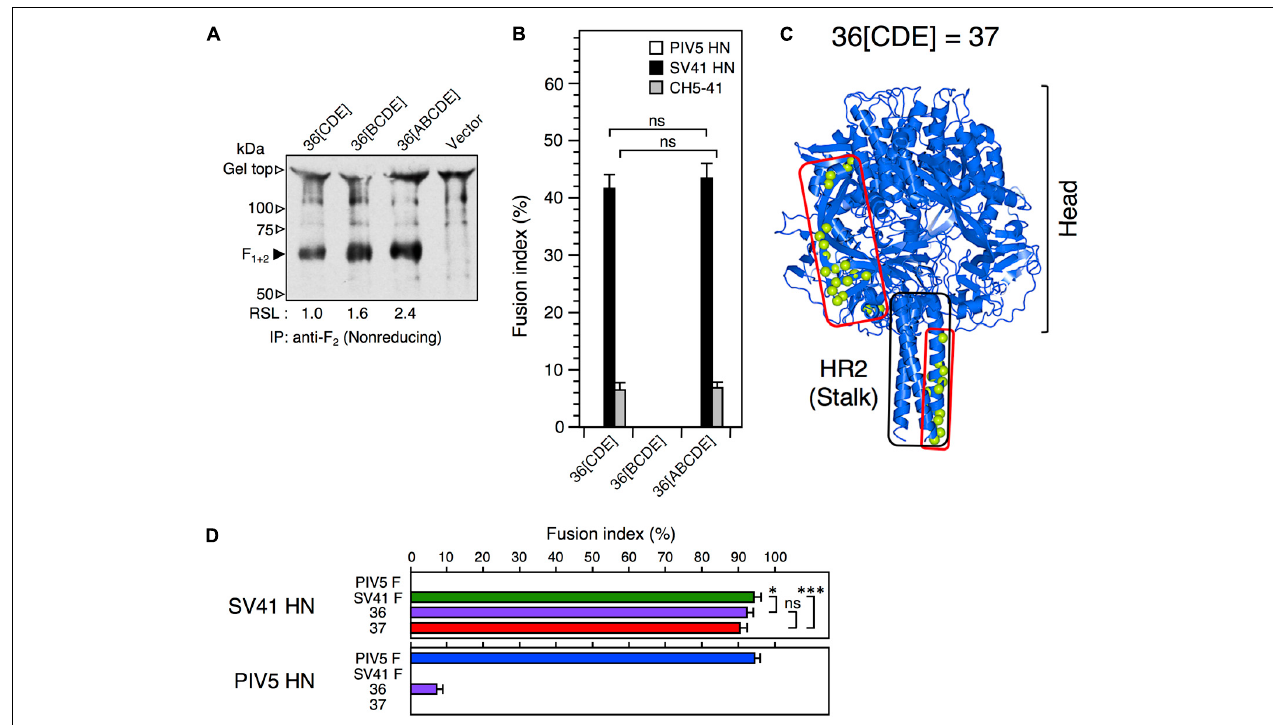
FIGURE 3 | No. 37 is a more SV41 F-like protein than no. 36. (A) Detection of the F proteins in the plasmid-transfected cells. Subconfluent BHK cells in six-well culture plates were transfected with 2 µ g/well of F expression vector. The biotinylated F proteins expressed on the cell surface were detected by immunoprecipitation with anti-PIV5 F 2 rabbit serum as described in the legend for Figure 1C . Vector: pcDL-SR α expression vector used as the negative control. RSL, relative surface localization. (B) HN protein specificity of the F proteins. Subconfluent BHK cells in six-well culture plates were transfected with 2 µ g/well of the pcDL-SR α expression vector encoding each F protein together with 1 µ g/well of the pcDL-SR α expression vector encoding each HN protein. After 12 h of incubation, the cells were fixed with 4% paraformaldehyde and the average fusion index was determined as described in the section “Materials and Methods”; error bars indicate standard deviation. The representative data of more than three independent experiments are shown. The fusion indices are not normalized to the cell surface-localization levels; the normalized data are shown in Supplementary Figure S5B . The statistical significance was evaluated by one-way ANOVA as described in the section “Materials and Methods”. ns, not significant. (C) Predicted three-dimensional structure of no. 37. The side view of the no. 37 trimer is drawn as a ribbon model on the basis of the crystal structure of PIV5(WR) F protein (PDB ID: 4WSG). The amino acid sequence identify between the ectodomains (amino-terminal 477 residues) of no. 37 and the PIV5 F protein is 93.6%. Light green balls surrounded by red lines indicate the positions of SV41 F-derived 36 amino acids; those in only one protomer are shown for clarity. (D) F protein specificity of the HN proteins. Subconfluent BHK cells in six-well culture plates were transfected with a mixture of 0.2 µ g/well of each HN-encoding vector and 2 µ g/well of each F-encoding vector. The transfected cells were fixed with 4% paraformaldehyde at 24 h post transfection and the average fusion index was determined as described in the section “Materials and Methods”; error bars indicate standard deviation. The representative data of more than three independent experiments are shown. The fusion indices are not normalized to the cell surface-localization levels. The statistical significance was evaluated by one-way ANOVA as described in the section “Materials and Methods” ( ∗ p < 0.05, ∗∗∗ p < 0.01, n = 10). ns, not